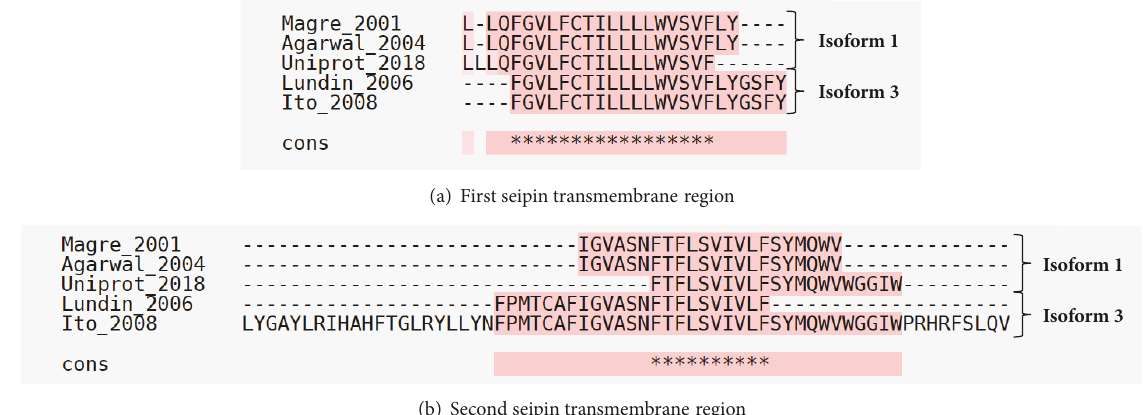
Figure 2: Alignment of transmembrane regions of seipin. Multiple alignments of seipin isoforms were performed through T-Coffee [32]. Many authors predicted the transmembrane regions of seipin and the amino acid positions are reviewed in Table 1 [4, 6, 14, 33, 34]. It is possible to observe that, even with differences, some regions are conserved in the prediction for the same isoform or between different isoforms. Isoform 2 was omitted due to the low number of works with it. Pink color represents identical alignments; yellow corresponds to similar alignments; and green regions show different alignments. ∗ corresponds to an equal match. Cons: consensus